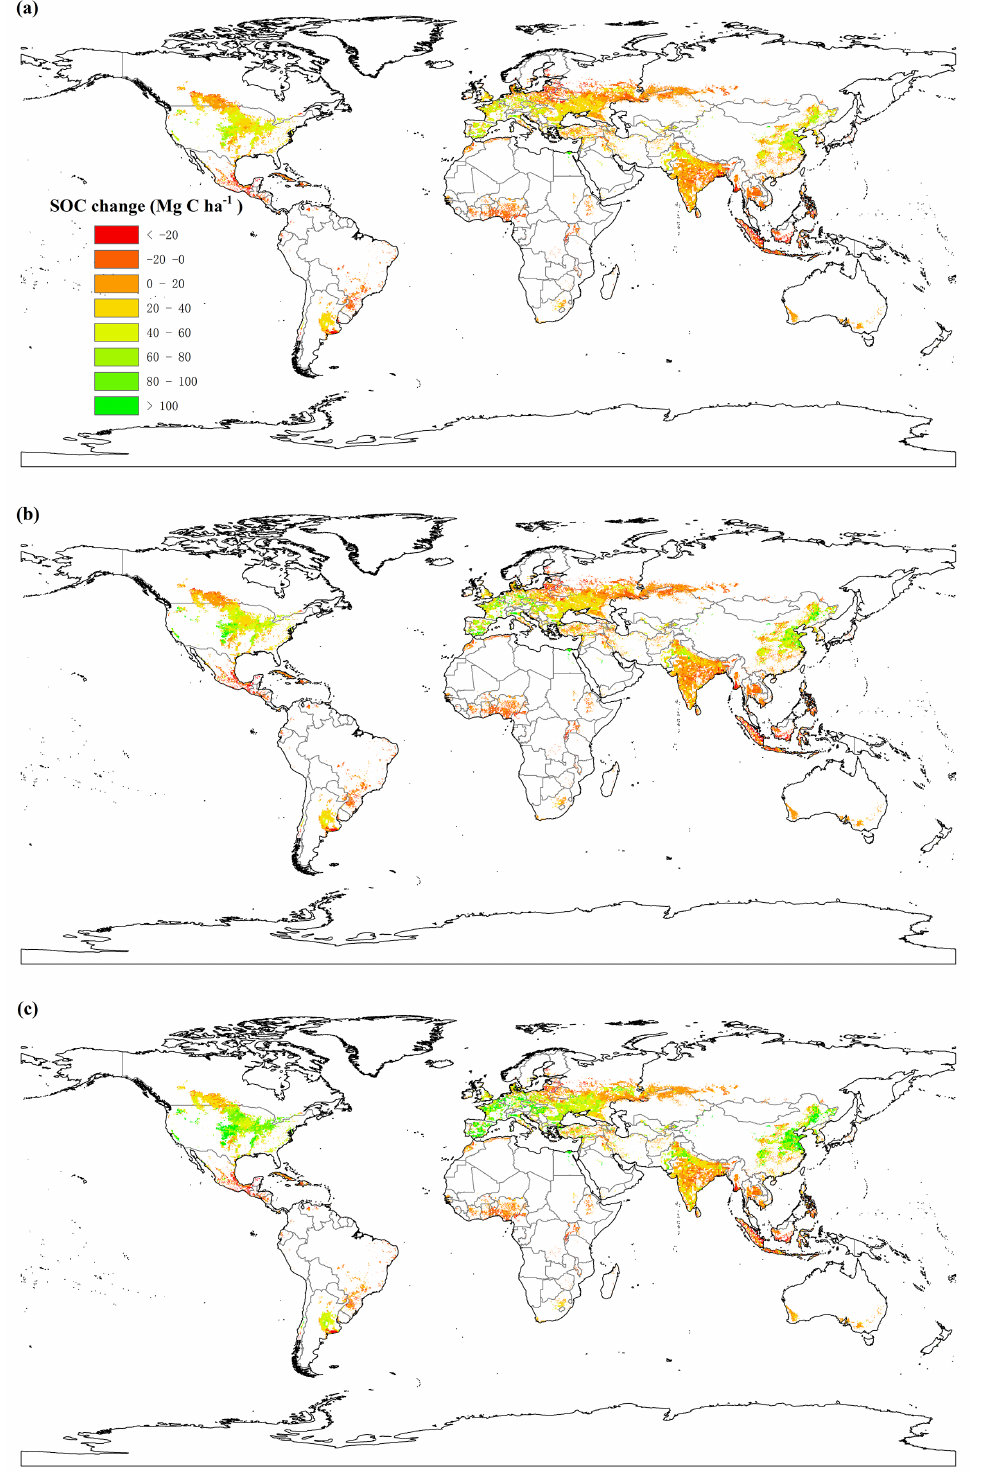
Figure 2. Spatial distribution of the SOC change (1961–2014, MgCha − 1 ) across the main global cereal cropping regions under different above-ground crop residue retention rates of 30% (a) , 60% (b) and 90% (c)